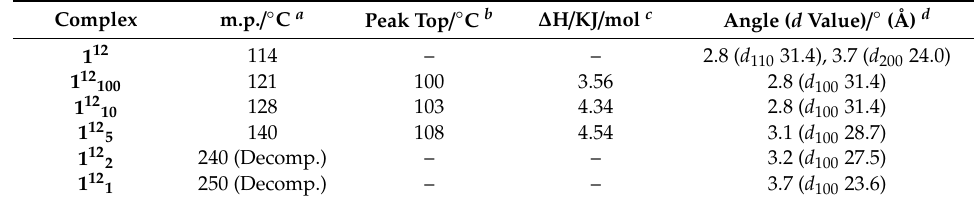
Figure 4. DSC traces of 1 12 and complexes of 1 12 with BSA for 1 12 100 , 1 12 10 , and 1 12 5 on 1st cooling ( a ) and 2nd heating ( b ). Table 1. Phase transition behavior and d values estimated from XRD for 1 12 and complexes of 1 12 with BSA.